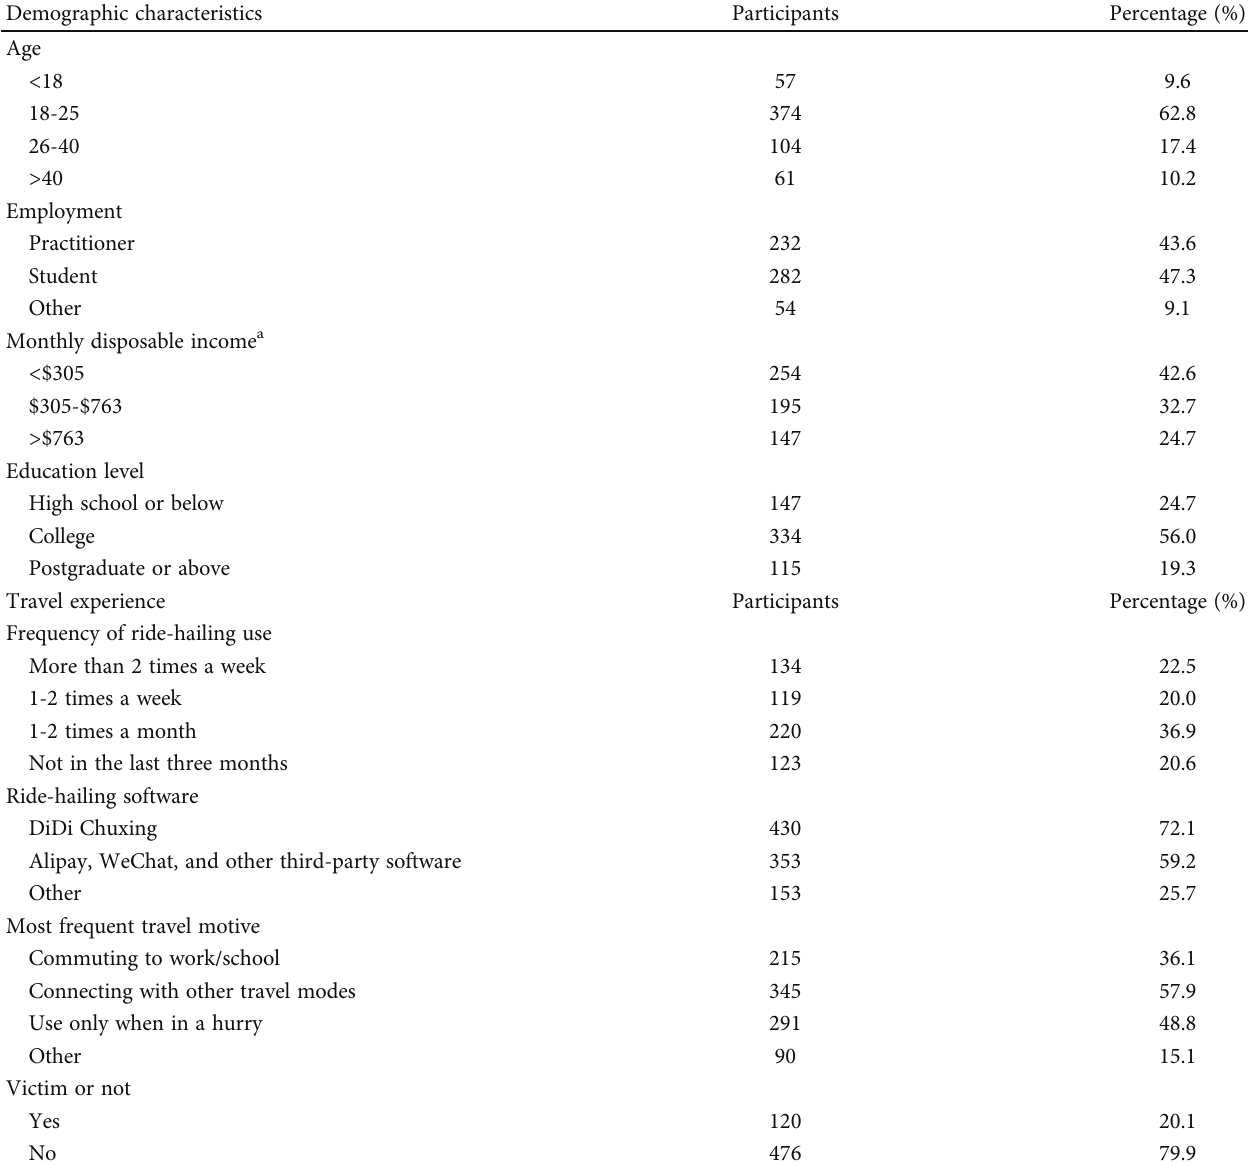
Table 3: Survey sample